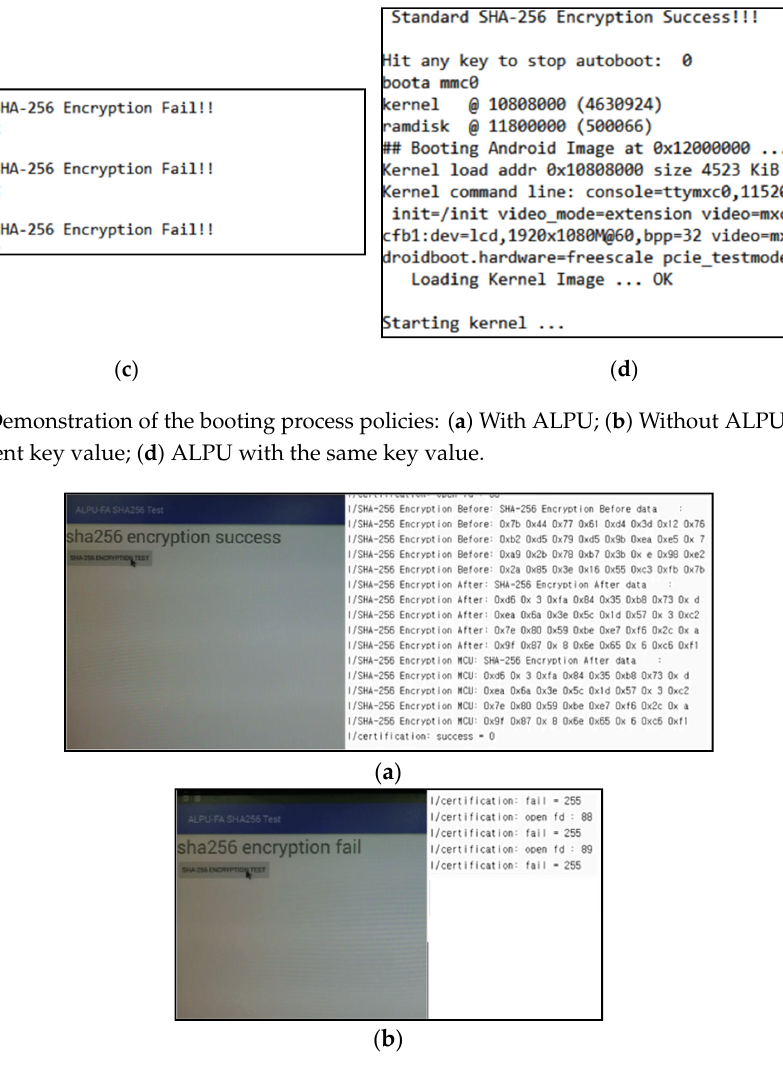
Figure 6. Demonstration of the booting process policies: ( a ) With ALPU; ( b ) Without ALPU; ( c ) ALPU with different key value; ( d ) ALPU with the same key value.